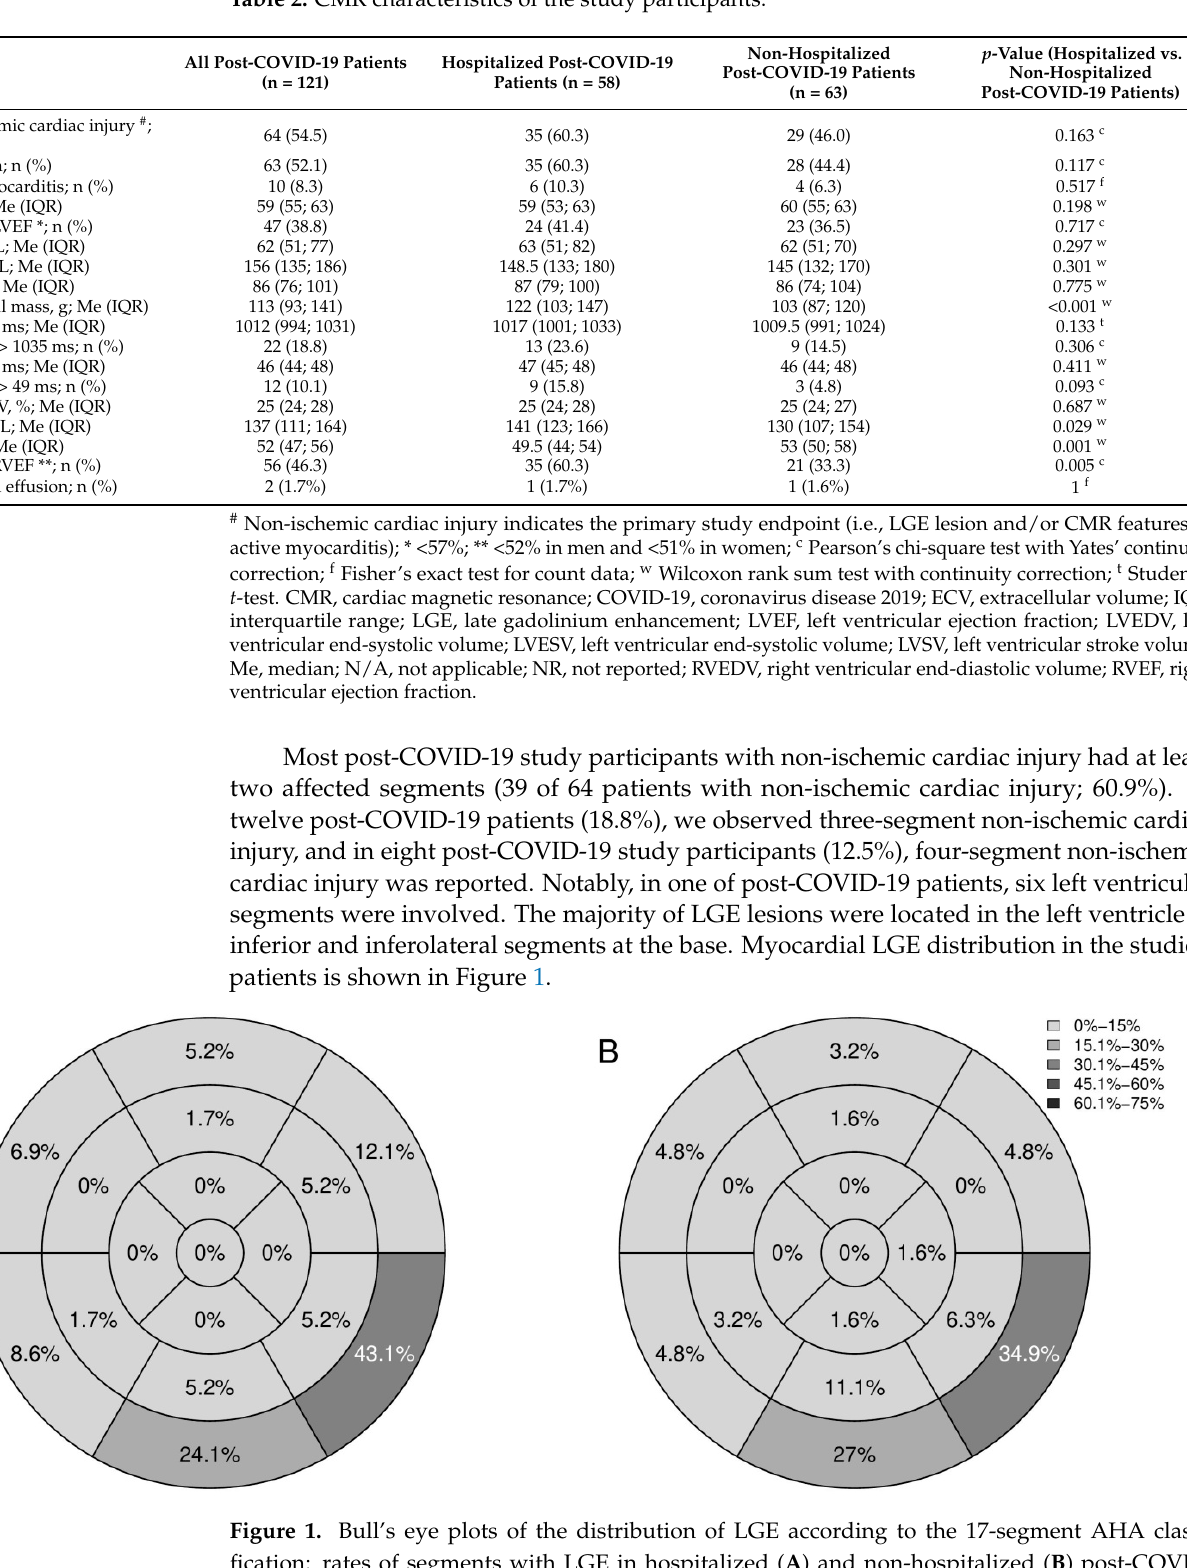
Table 2. CMR characteristics of the study participants.